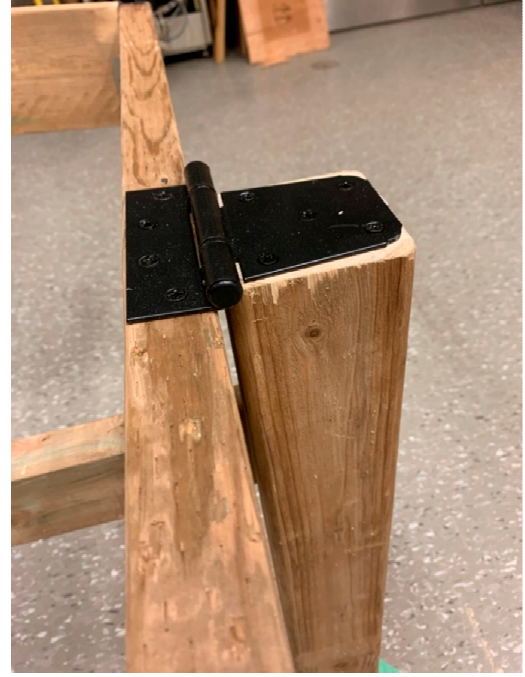
Figure 4. Installation of the frame onto the front posts using galvanized gate hinges.